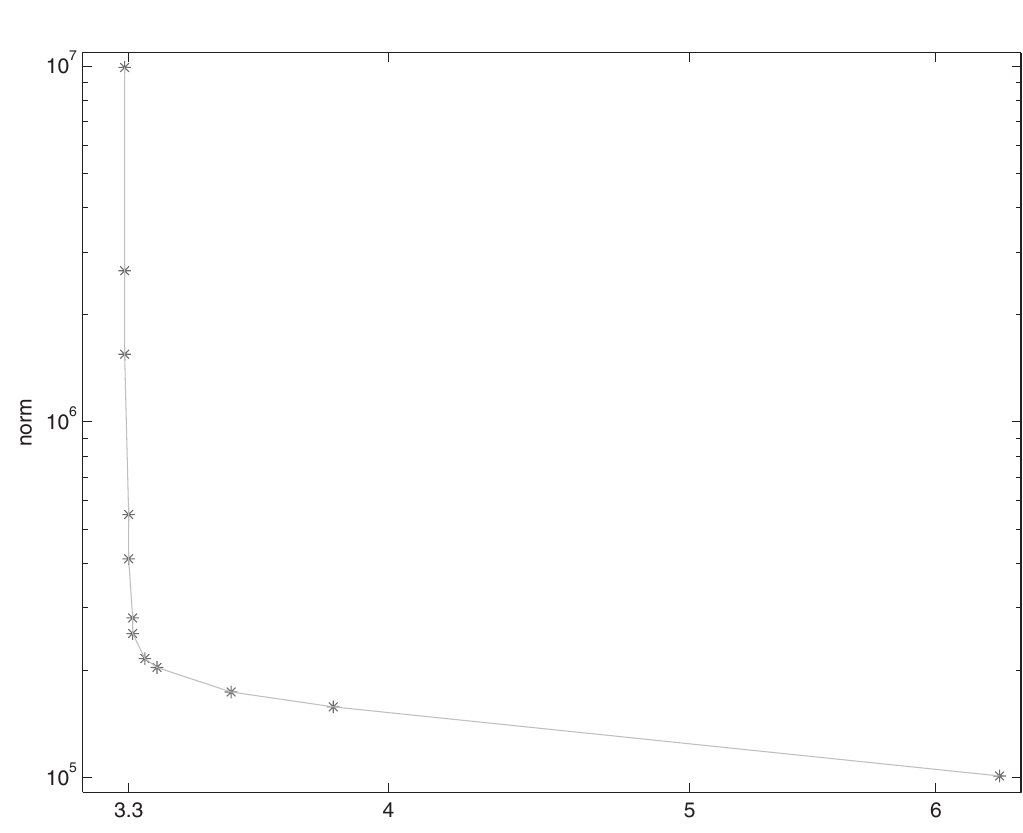
Fig. 2. Trade-off curve of the spatial norm ( nTyr –1 /4 π ) vs. misfit ( nTyr –1 ) for EU_MIX model. Logaritmic